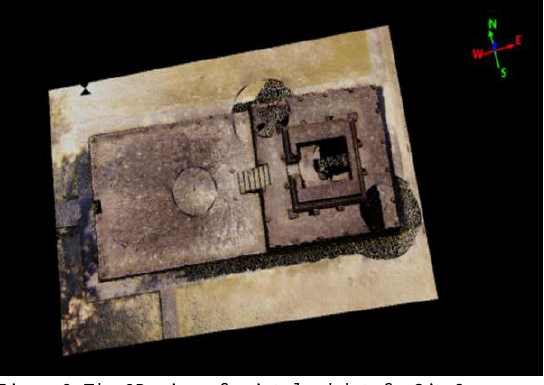
Figure 6: The 3D view of point cloud data for Site